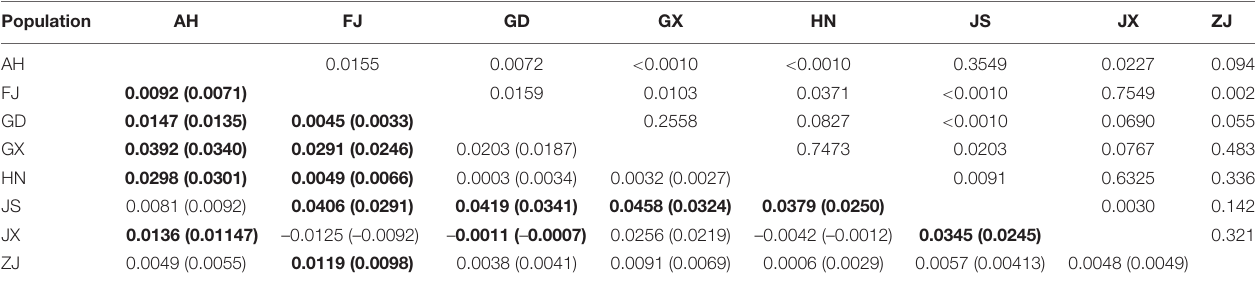
TABLE 6 | Pairwise population genetic differentiation (F ST , lower triangle) and P -values (upper triangle) among eight populations of Phyllotreta striolata based on microsatellites.